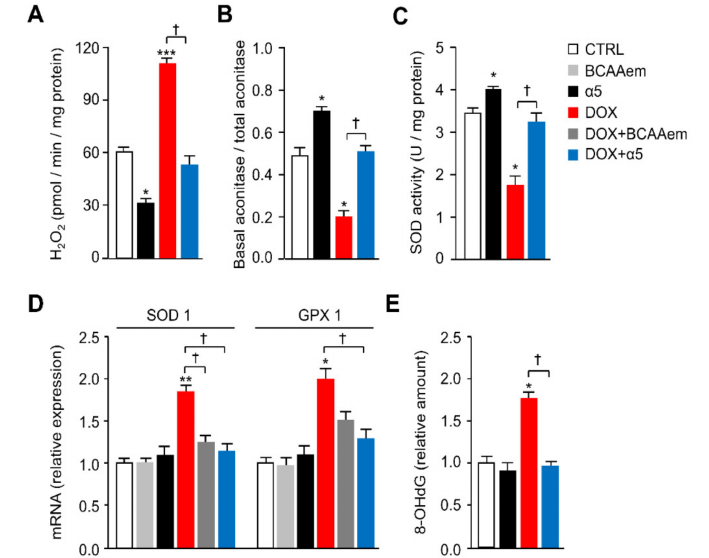
Figure 4. α 5 Supplementation prevents DOX-induced oxidative stress in HL-1 cardiomyocytes. ( A ) Mitochondrial H 2 O 2 release, ( B ) basal aconitase / total aconitase ratio, and ( C ) superoxide dismutase activity (SOD) in HL-1 cells ( n = 3 experiments). ( D ) superoxide dismutase 1 (SOD1) and glutathione peroxidase 1 (GPX1) mRNA levels were analysed by quantitative RT-PCR. Relative expression values for the untreated (CTRL) cells were taken as 1.0 ( n = 5 experiments). ( E ) Total DNA oxidative damage measured as 8-hydroxy-2’-deoxyguanosine (8-OHdG)